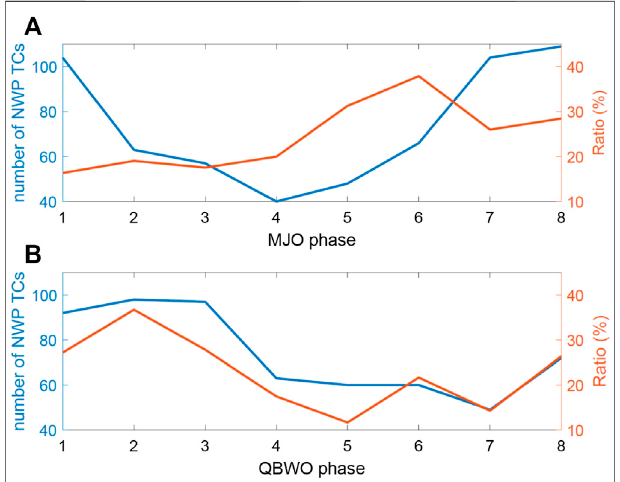
FIGURE3| ThenumberoftotalNWPTCs(blue)andtheratio(red)ofthe nonlocal TCs and the total NWP TCs in each phase of (A) MJO, and (B) QBWO.